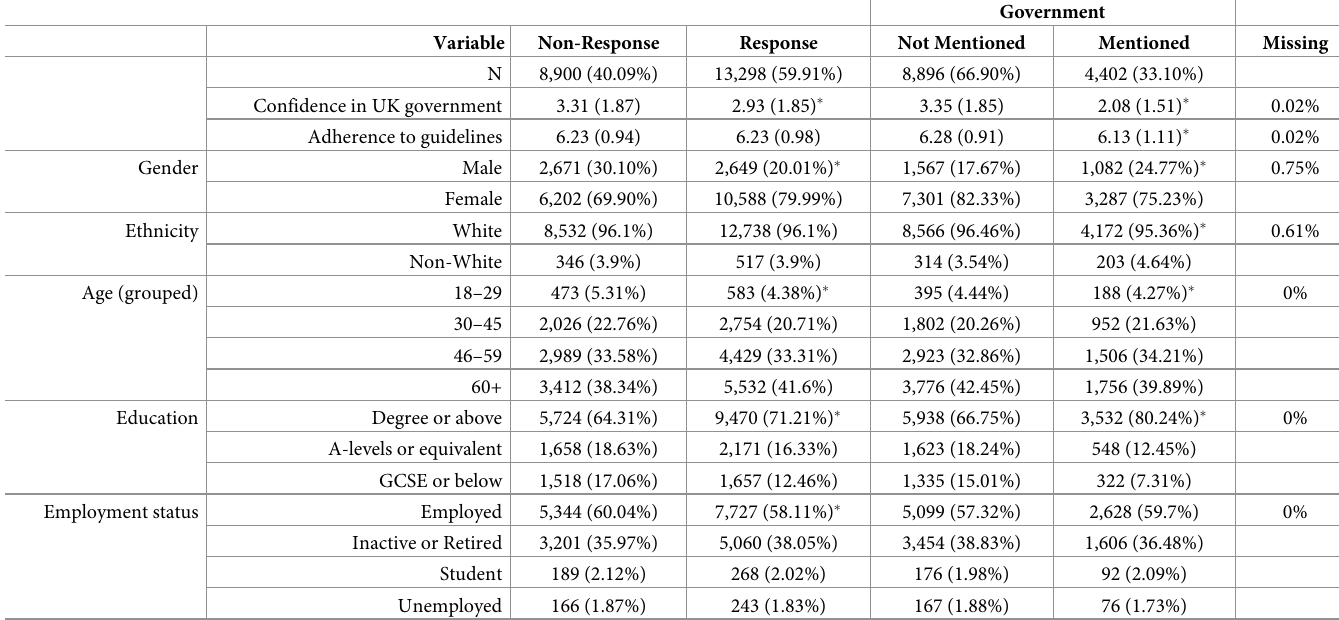
Table 2. Sample descriptive